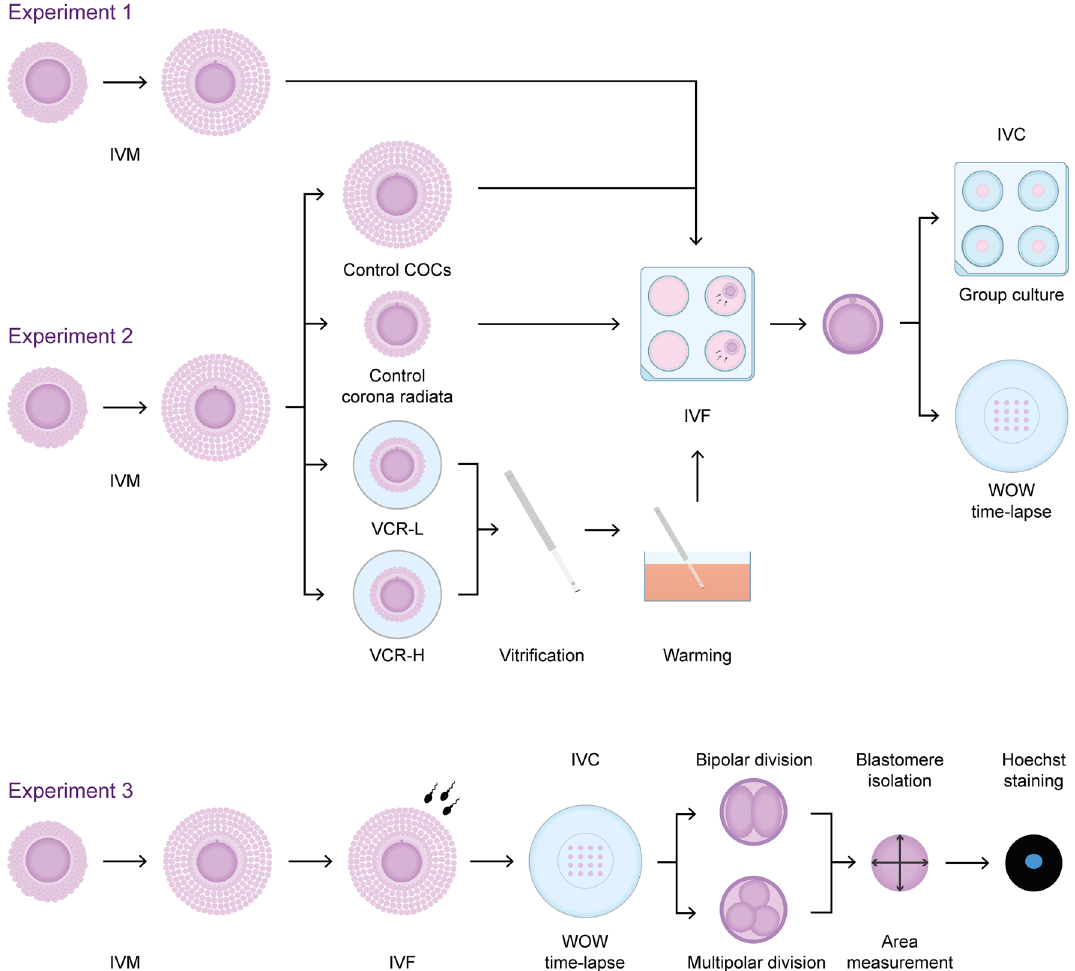
Figure 4. Experimental set-up. Experiment 1: After in vitro maturation (IVM) and in vitro fertilization (IVF), presumed zygotes derived from fresh cumulus enclosed oocytes were divided for in vitro culture (IVC) between traditional group culture (n = 582) and Well of the Well (WOW) time-lapse system (n = 351) to evaluate developmental potential and morphokinetics during all culture (8 days). Experiment 2: After IVM, oocytes were divided in 4 groups, Control: fresh cumulus enclosed oocytes (n = 709); Corona radiata (CR): fresh oocytes partially denuded to leave only the CR (463). VCR-H: CR oocytes vitrified with a protocol using high concentrations of cryoprotectants (15%) in equilibration solution (n = 274); VCR-L : CR oocytes vitrified with a protocol using a low cryoprotectants concentration (3%) in equilibration solution (n = 330). After IVF they were split in Group culture and WOW time-lapse for developmental and morphokinetics analyses. Experiment 3: Presumptive zygotes were cultured in WOW time-lapse systems, and collected immediately after the first cleavage, they were classified as bipolar (cleaved in two cells; n = 22) or multipolar (cleaved directly in three or more; n = 20) division, zona pellucida was removed and individual blastomeres were measured, fixed, and stained with Hoechst 33342 for nuclear